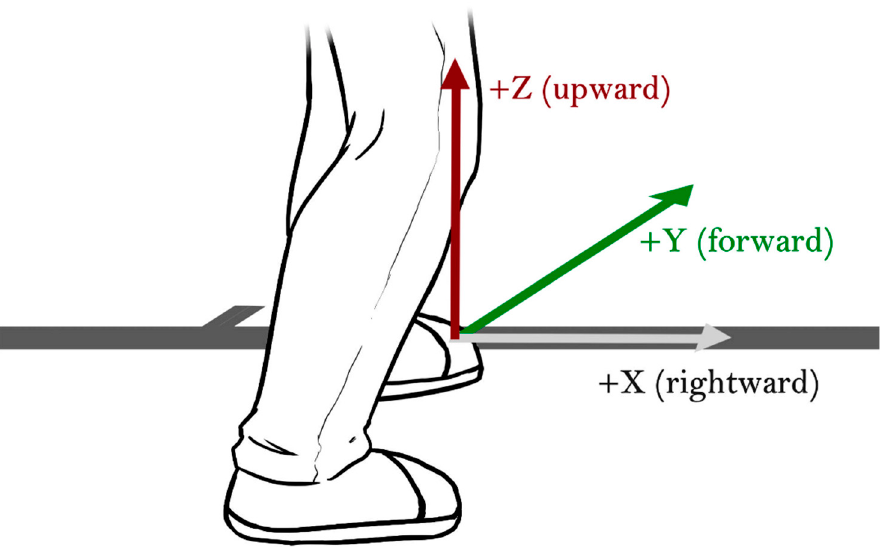
Figure 1. Orientation and origin of the global coordinate system.